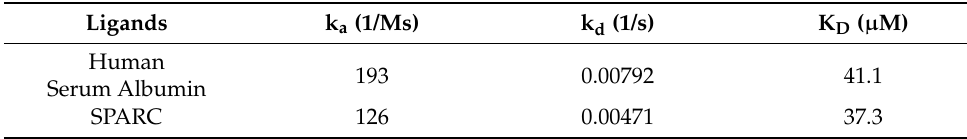
Figure 1. Binding ICG to HSA ( a ) Optical imaging of ICG and ICG-HSA complex. Saturation binding analysis using Native PAGE gel electrophoresis in a mixture of HSA and ICG at various concentrations. After the fluorescence signal was unmixed by Lumina II Imaging System, the ICG-HSA complex was presented as green, and the unbound ICG was presented as red; ( b ) image of Native PAGE gel after Coomassie blue staining. Table 1. Surface Plasmon Resonance (SPR) analysis.